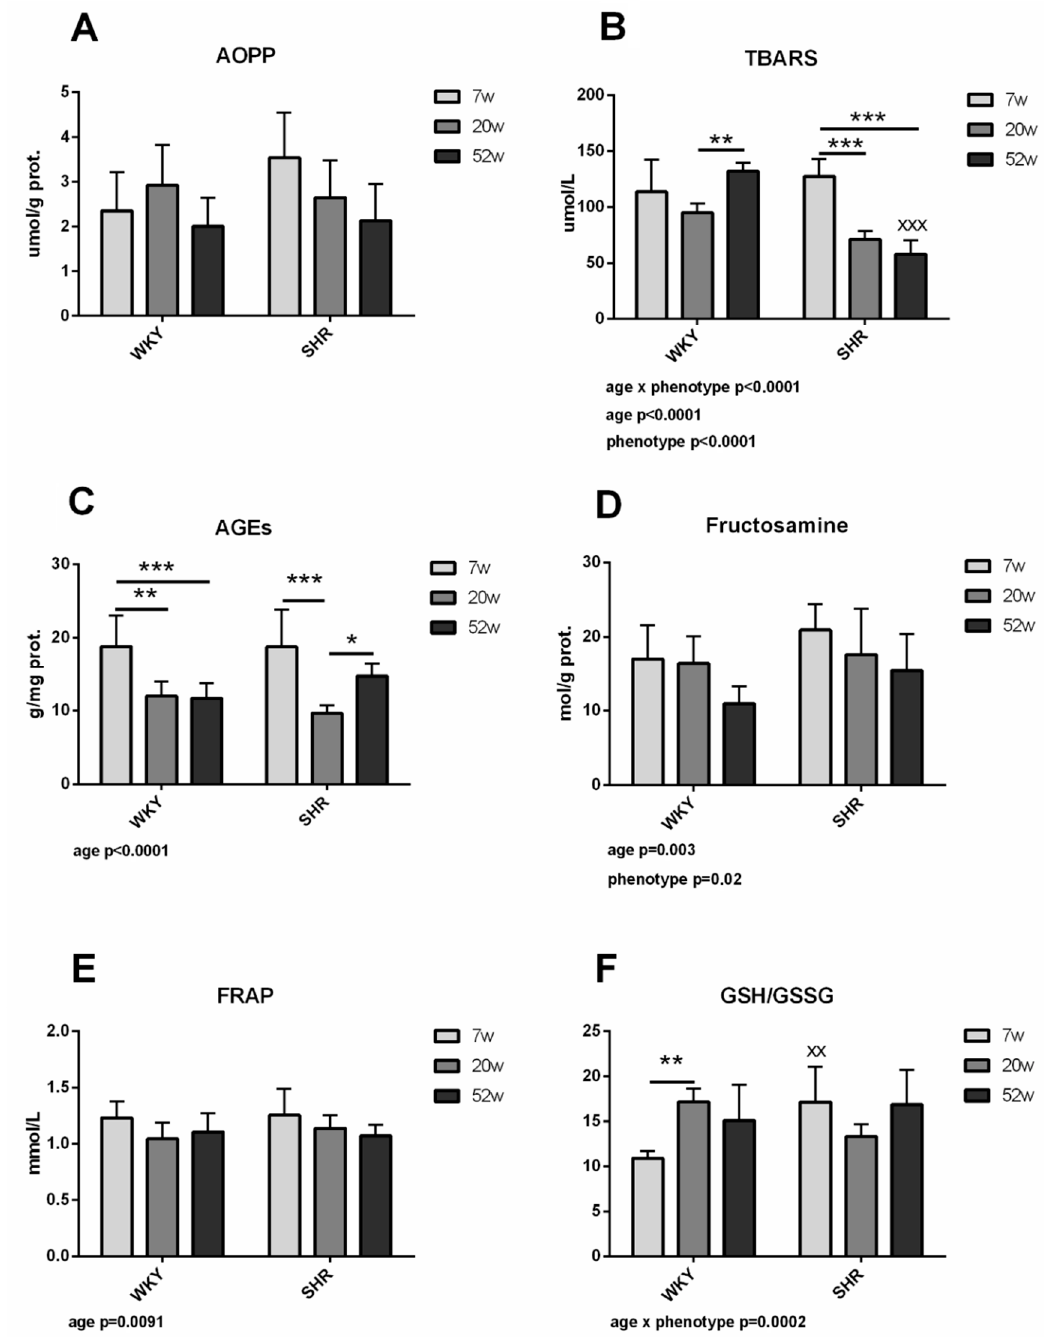
Figure 2. Markers of oxidative stress: markers of oxidative damage—AOPP ( A ) and TBARS ( B ), carbonyl stress—AGEs ( C ) and fructosamine ( D ) and antioxidant capacity—FRAP ( E ) and GSH/GSSG ( F ). The data are presented as means ± SD. Statistical significance: * represents p < 0.05, ** represents p < 0.01 and *** p < 0.001. XX represents p < 0.01 and XXX p < 0.001 between the age-matched different